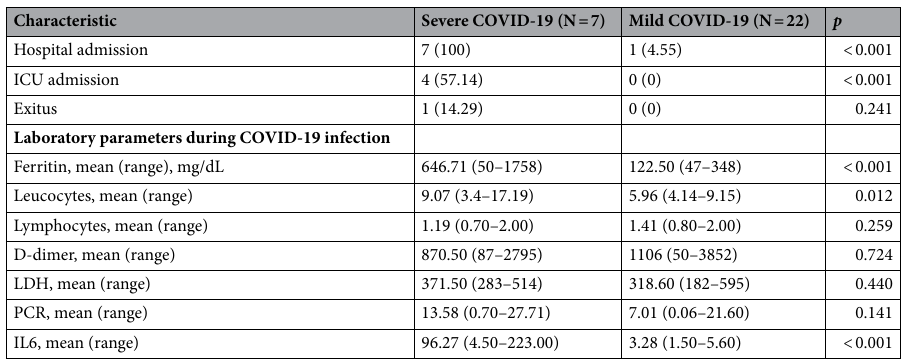
Table 2. Severe and mild RT-qPCR confirmed COVID-19 lupus patients*. *Except where indicated otherwise, values are the number (%). RT-qPCR Reverse-transcriptase quantitative PCR; SLE Systemic lupus erythematosus; CLE Cutaneous Lupus Erythematosus; SLEDAI-2K Systemic Lupus Erythematosus Disease Activity Index 2000; SLICC-DI Systemic Lupus International Collaborating Clinics Damage Index. MMF mycophenolate mofetil; EC-MPS enteric-coated mycophenolate sodium. Reference ranges are as follows: anti- double-stranded DNA antibodies, < 15 IU per milliliter; serum C3 (mg/dL), 85 to 110; serum C4 (mg/dL), 10 to